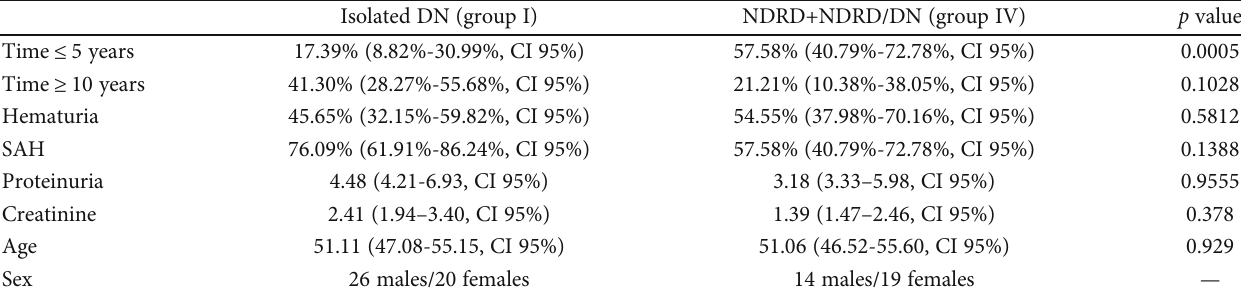
Table 3: Comparison between groups DN (group I) and NDRD+NDRD/DN (group